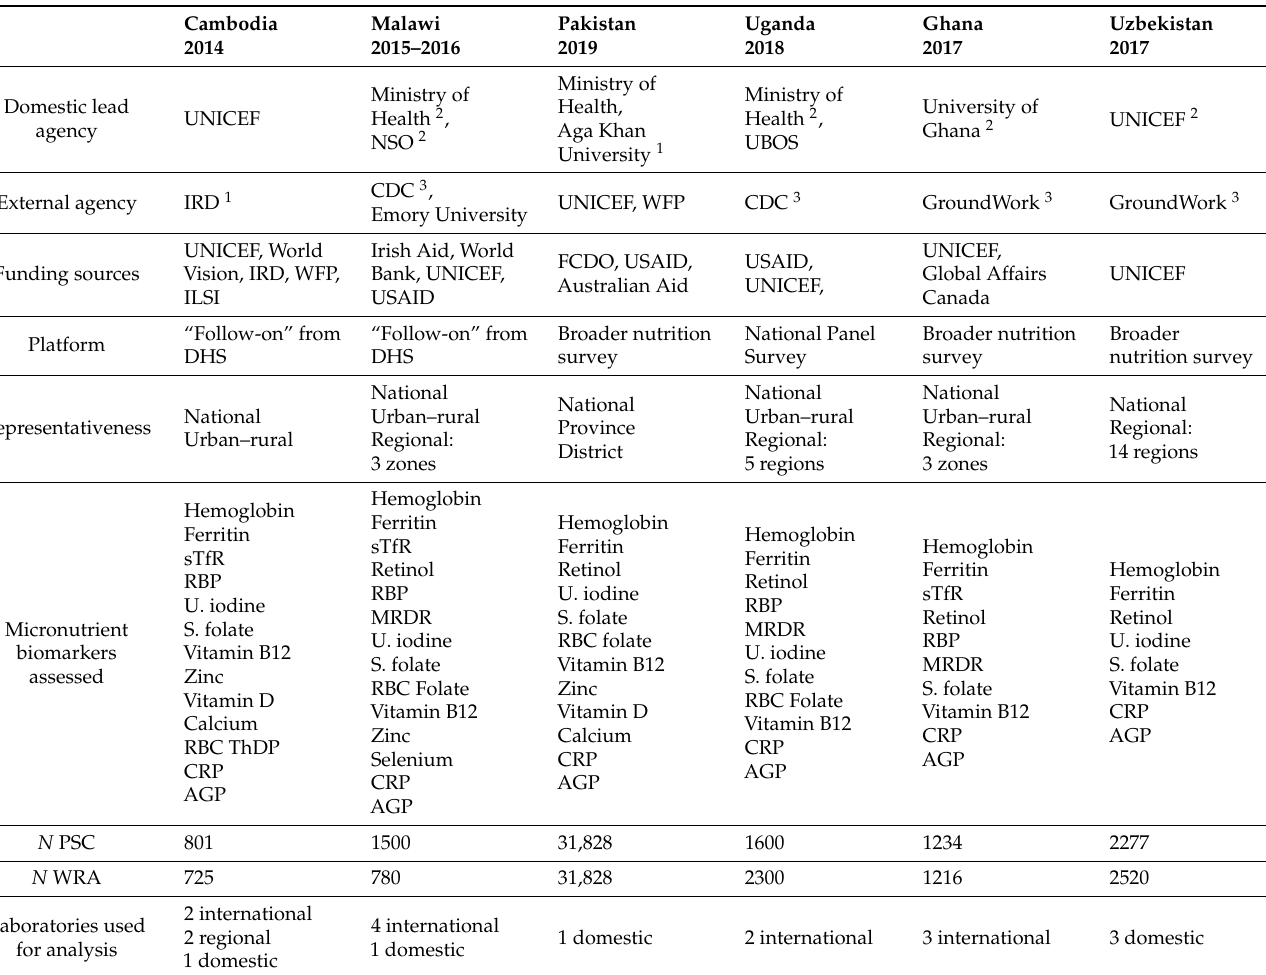
Table 1. Characteristics of the six surveys assessing biomarkers of micronutrient status for which key informant interviews were